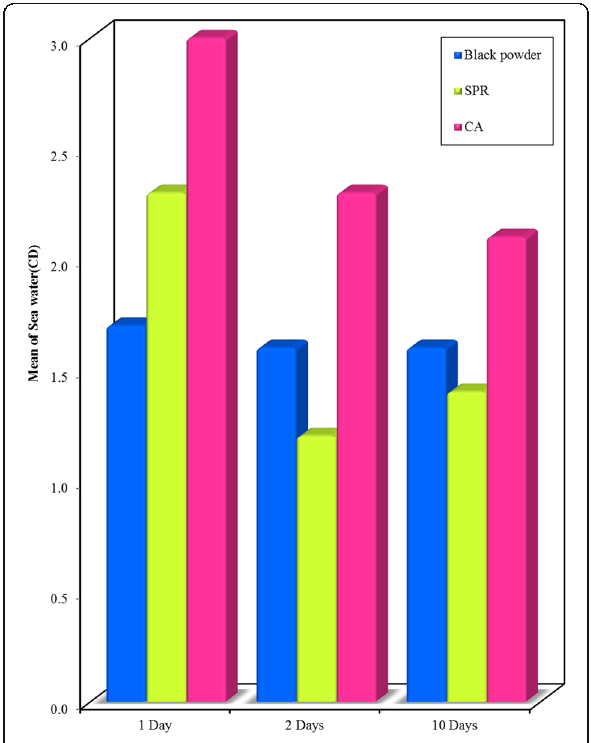
Fig. 8 Bar graph - Comparison between the Black powder, SPR and CA development techniques at different time intervals (1, 2, and 10 days) on plastic surface (CD) recovered from sea water . It shows higher mean visibility score of prints developed using CA